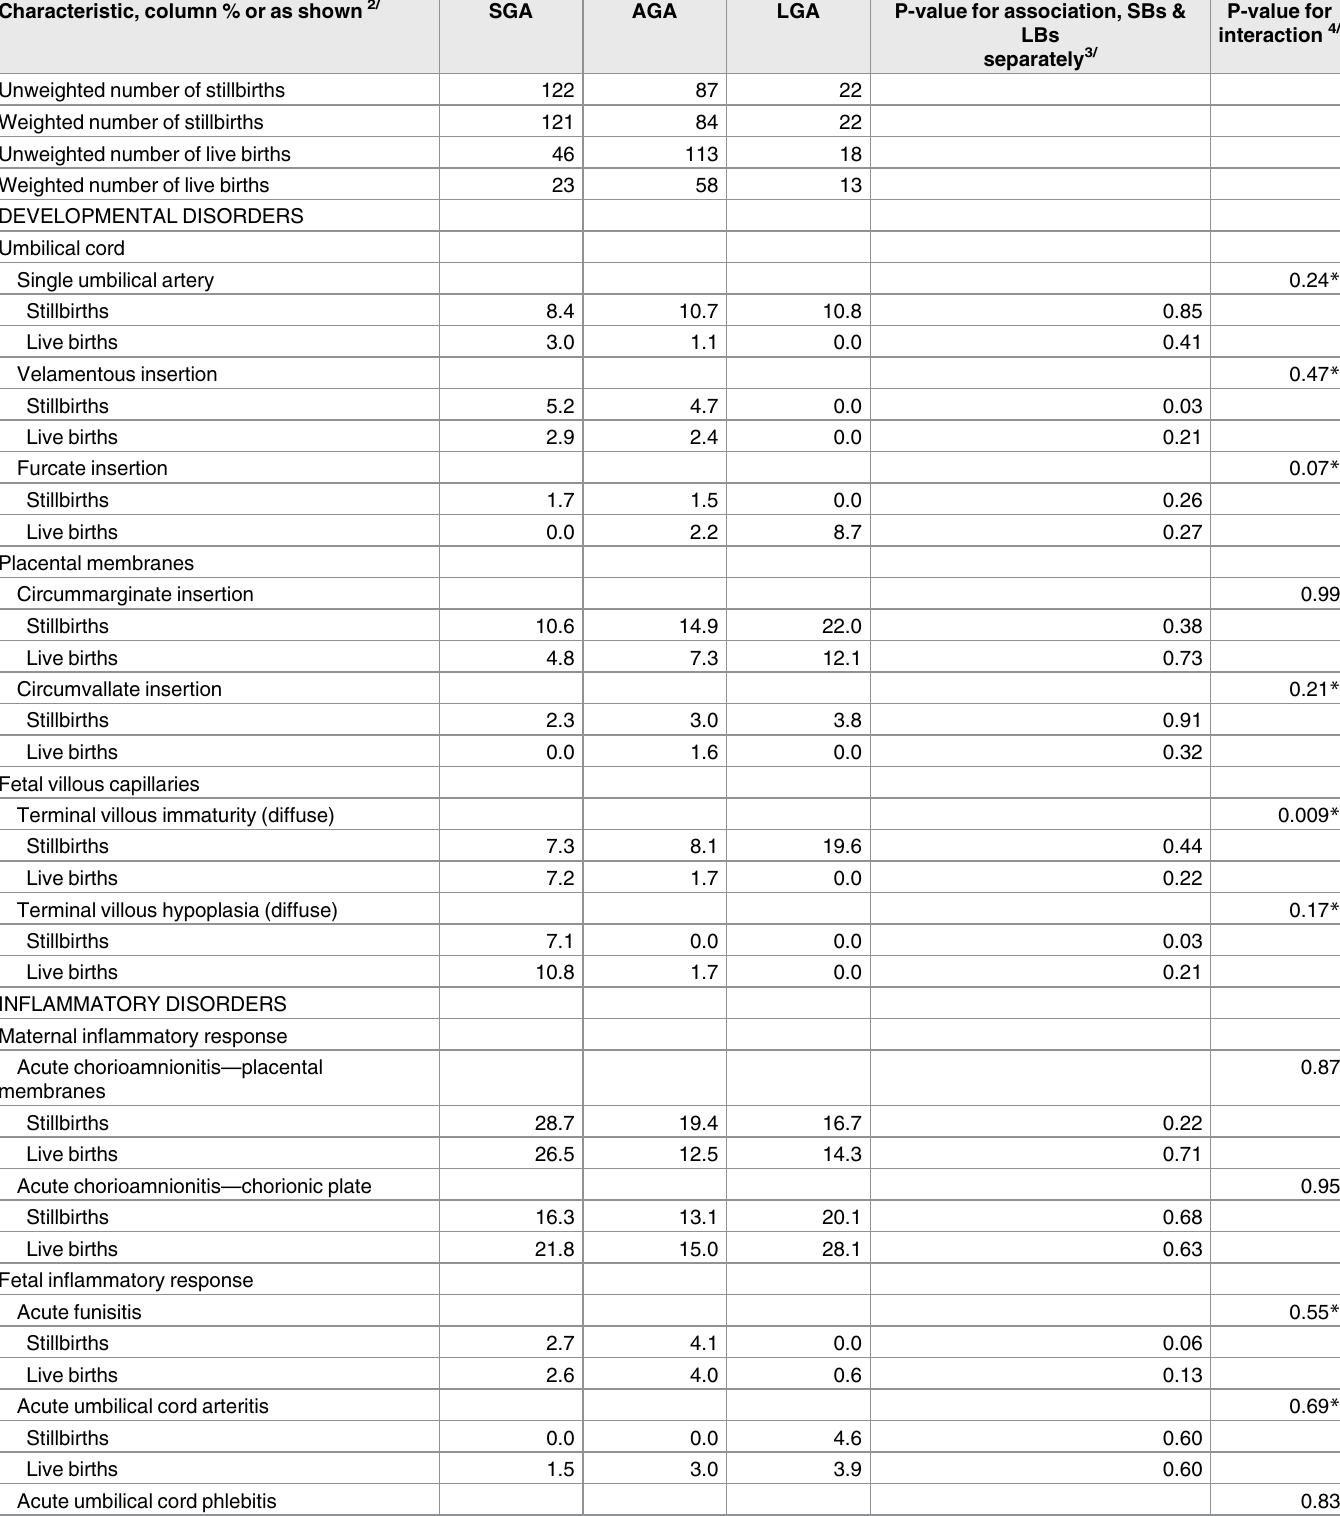
Characteristic, column % or as shown